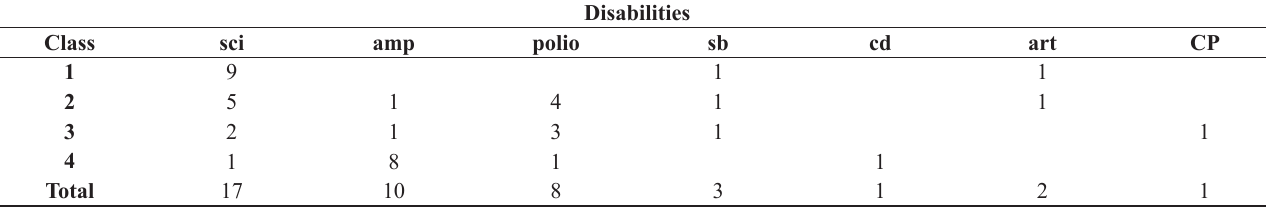
Table 2. Distribution of subjects according to disabilities and wheelchair basketball